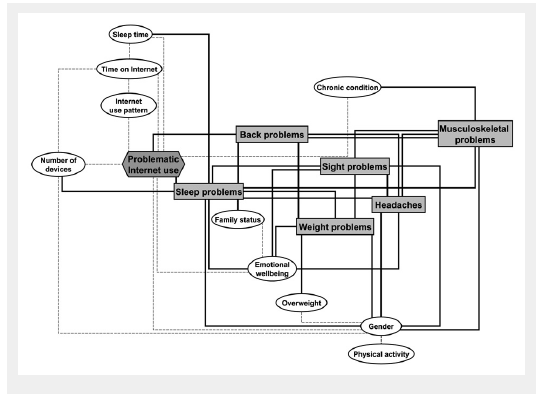
Log-linear model representing the associations between significant variables.